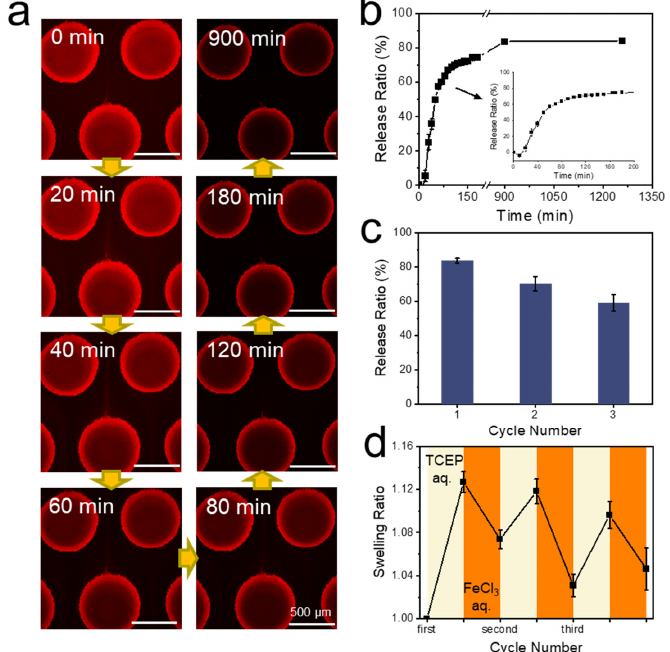
Figure 6. ( a ) Development of the fluorescence images of the PNiPAAm hydrogel dots over time in the microfluidic chip, during the release of BSA-RhB-PDA (image height set to 80 µm). ( b ) Release profile of BSA over time derived from the fluorescence images of Figure 6a, analyzed by ImageJ. ( c ) Release ratios of BSA captured by PNiPAAm hydrogel over three cycles. ( d ) Swelling ratios of the PNiPAAm hydrogel dots in each capture and release cycle. Every cycle consists of two data points, representing the highest swelling with broken disulfide bonds after treatment with 0.01 M TCEP and the reduced swelling after reforming these bonds with 0.1 M FeCl 3 . For ( b – d ) at least three hydrogel dots were tested for each experimental point to obtain reliable data. Cyclic tests of protein capture and release have been performed following the com- plete characterization of the first cycle. Each cycle went through the seven steps of hydro- gel dots swelling, protein capture, protein release, and hydrogel dots shrinking, including all washing steps. The release ratio of protein decreased from 70.1% in the second cycle to 59.0% in the third cycle (Figure 6c). Essentially, each step resulted in a release rate of about 85% of the previous value leading to a release rate of 61% after three cycles (as 0.85^3 = 61%), which is close to the observed 59.0%. This decay was likely to continue over possible next cycles, but we did not address this point. A repeated capture and release of the device was hence possible, but declined in quality with each cycle. Swelling ratios of the hydrogel dots in cyclic tests were measured as well (Figure 6d). Every cycle consists of two data points, beginning from the first purging of 0.01 M TCEP aqueous solution and ending after the purging of 0.1 M FeCl 3 aqueous solution. The swelling ratios of hydrogel dots under TCEP reduction decreased marginally from 1.13 to 1.10, while swelling ratios of hydrogel dots under FeCl 3 oxidation were 1.07, 1.03, and 1.05 in the three cycles, following no pattern. It could be concluded that the swelling and shrinking of the hydrogel dots in